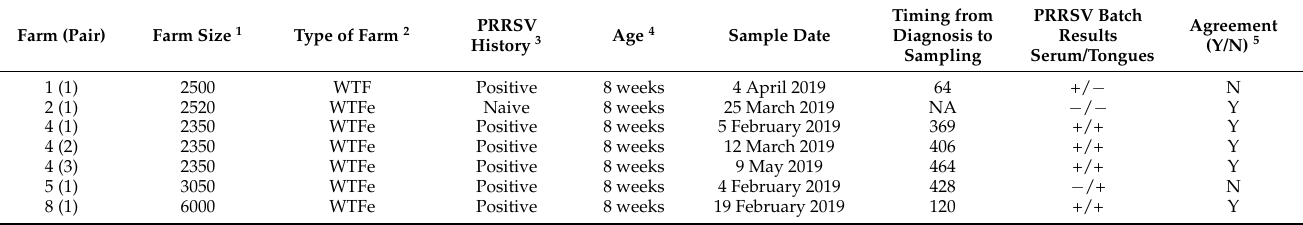
Table 2. Nursery farm and sample characteristics to study the agreement between paired serum and tongue samples (between brackets) from piglets belonging to the same production